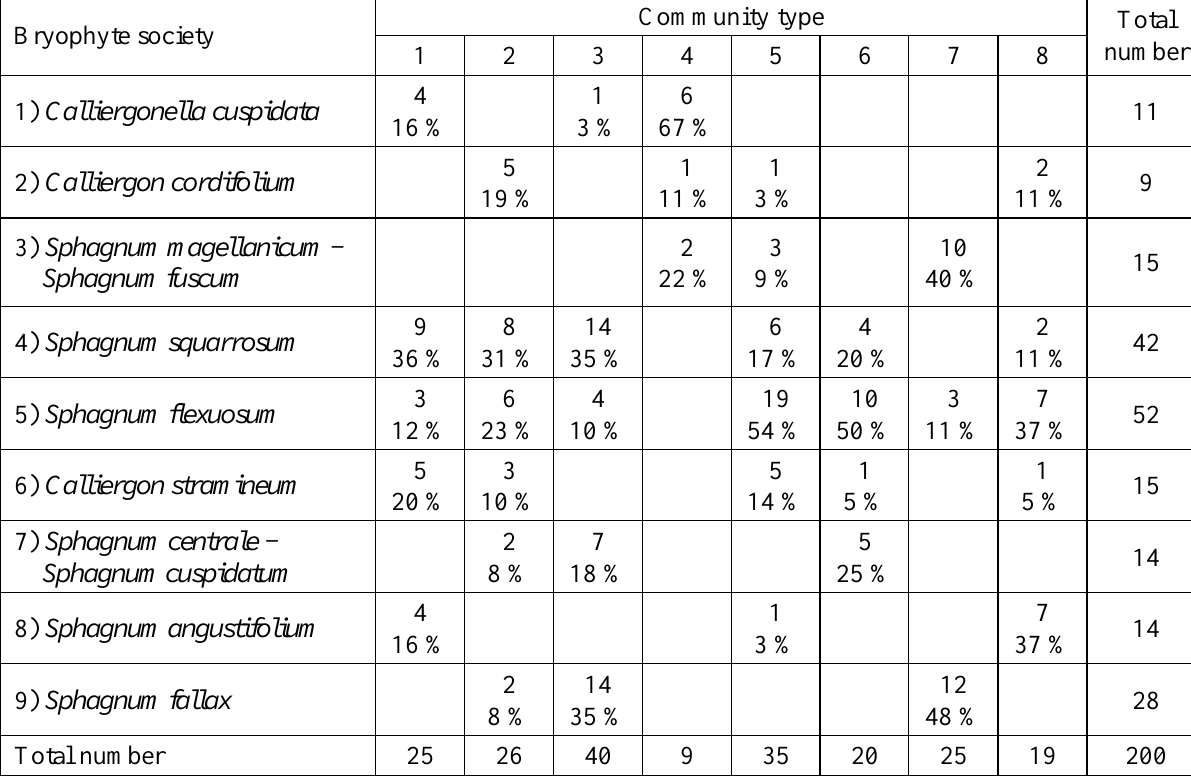
Table 9. Cross-tabulation of community types and bryophyte societies (number and percentage of their